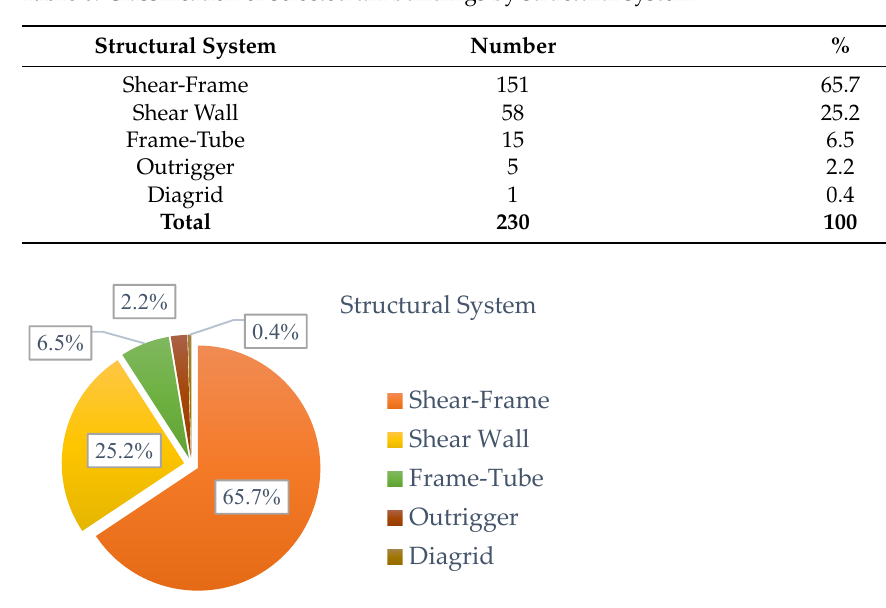
Table 6. Classification of selected tall buildings by structural system.